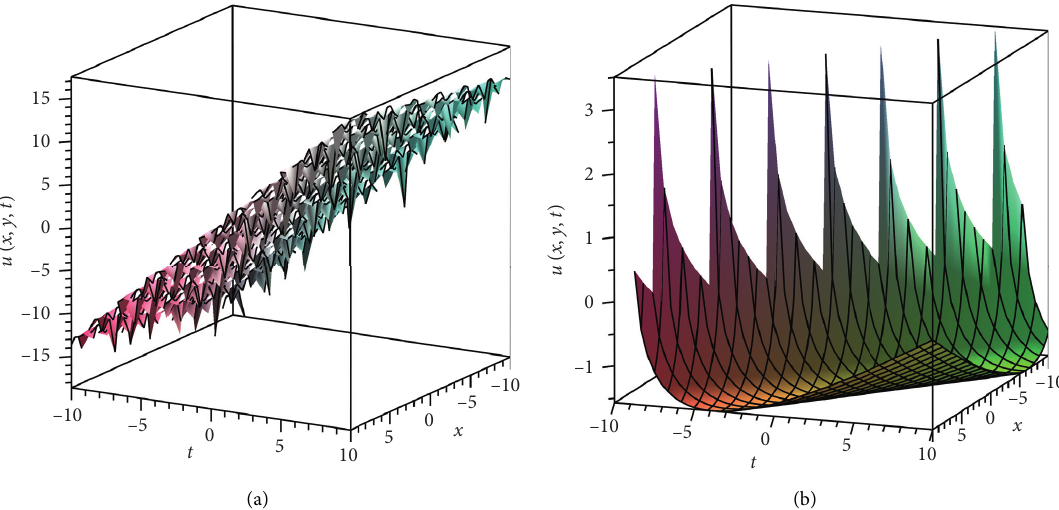
Figure 1: Plots of the solutions of (2) obtained using the ( G ′ / G 2 ) -expansion method and setting y � 0: (a) solution (23) and (b) solution (29).